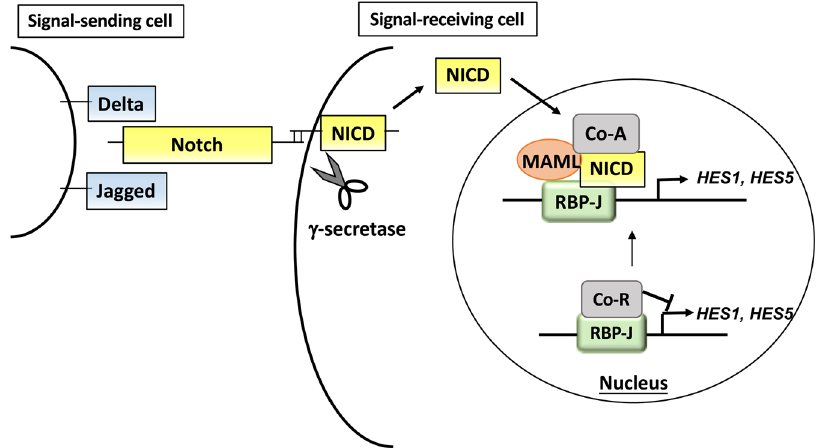
Figure 1. The Notch signaling pathway. Interaction between Notch and Delta or Jagged that exist on the surface of signal-sending cells triggers the cleavage of Notch protein by ADAM/TACE metalloproteases and γ -secretase to produce NICD. NICD moves to the nucleus to forms a heterotrimer with RBP-J and MAML to enhance transcription of target genes, such as HES1 and HES5 . NICD: Notch intracellular domain, MAML: mastermind- like protein (co-activator), HES1: hairy and enhancer of split 1, HES5: hairy and enhancer of split 5.